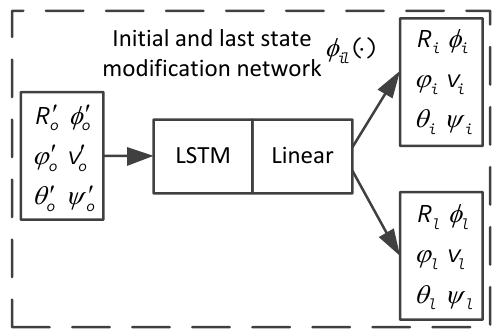
Figure 1. Initial and last modification network.